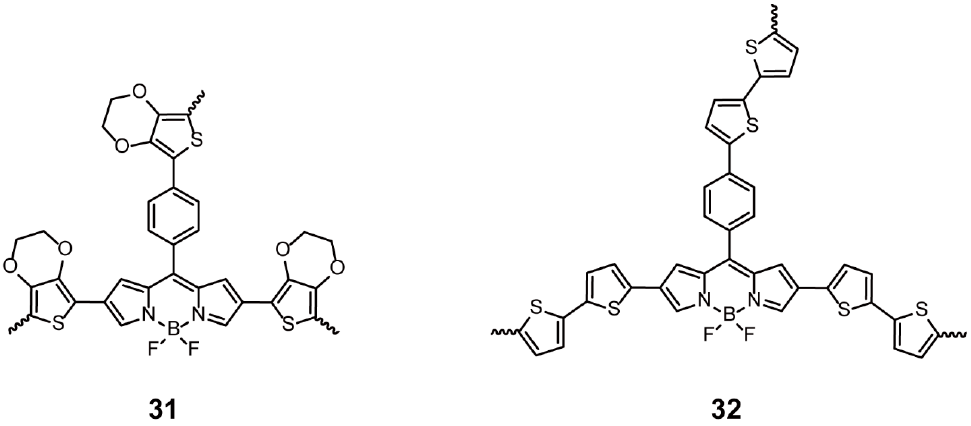
Figure 11. Chemical structures of polymers 31 and 32 (Reproduced with permission from Reference [24]. Copyright @ 2013 Elsevier Ltd).